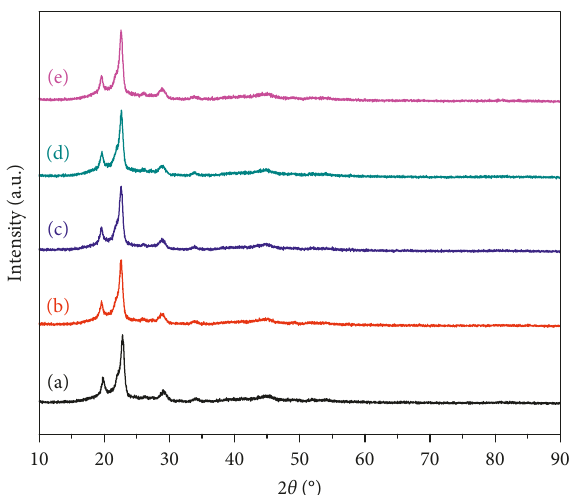
Figure 3: XRD patterns using X-ray of Cu K alpha radiation of the as-synthesized (a) pristine PBS, (b) 3CB-PBS, (c) 5CB-PBS, (d) 10CB-PBS, and (e) 15CB-PBS materials indicating the crystalline phase of PBS. The addition of CB shown herein as amorphous phase does not disrupt the structure of PBS matrix.